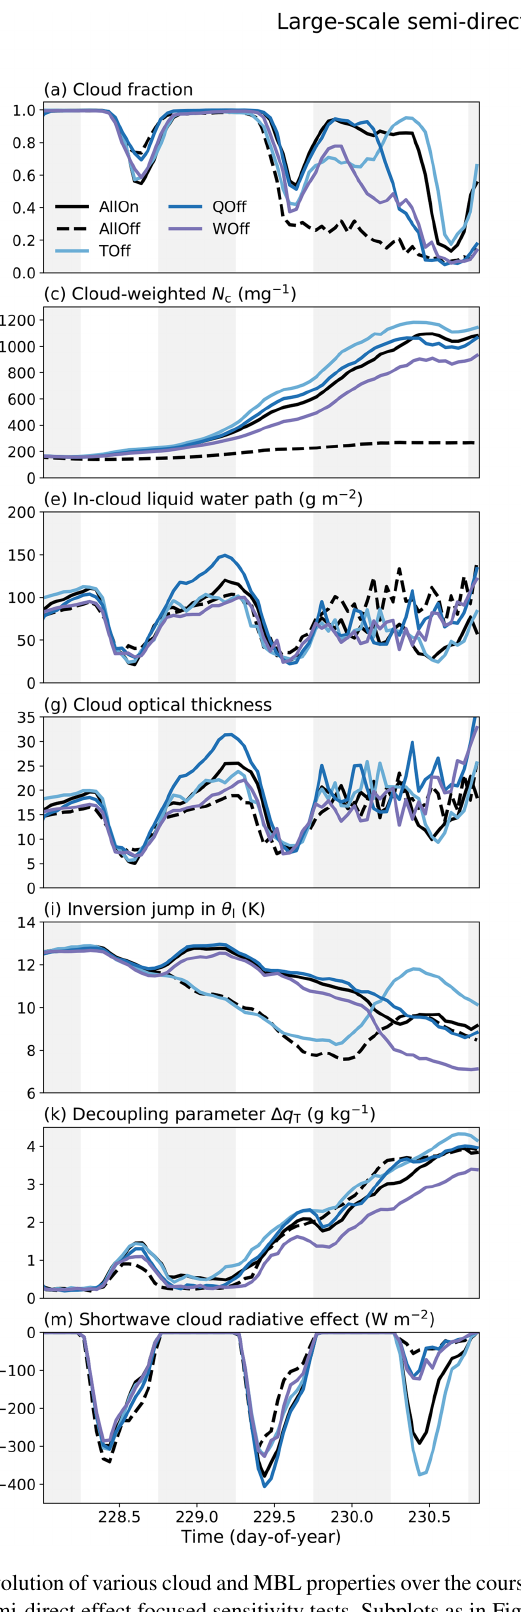
https://doi.org/10.5194/acp-22-12113-2022 Atmos. Chem. Phys., 22, 12113–12151,